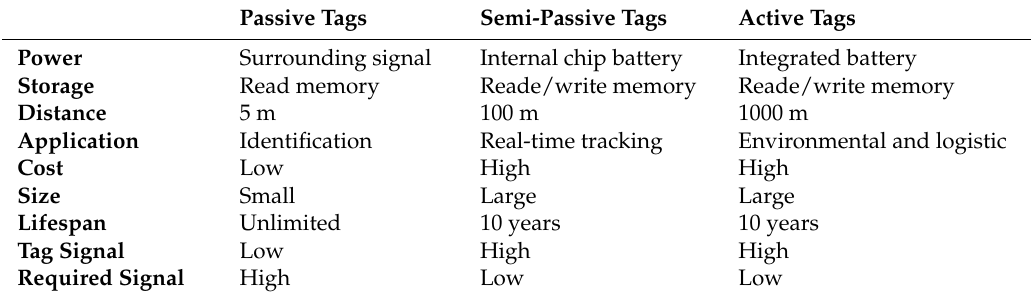
Table 1. Classification of RFID Tags [7,8].